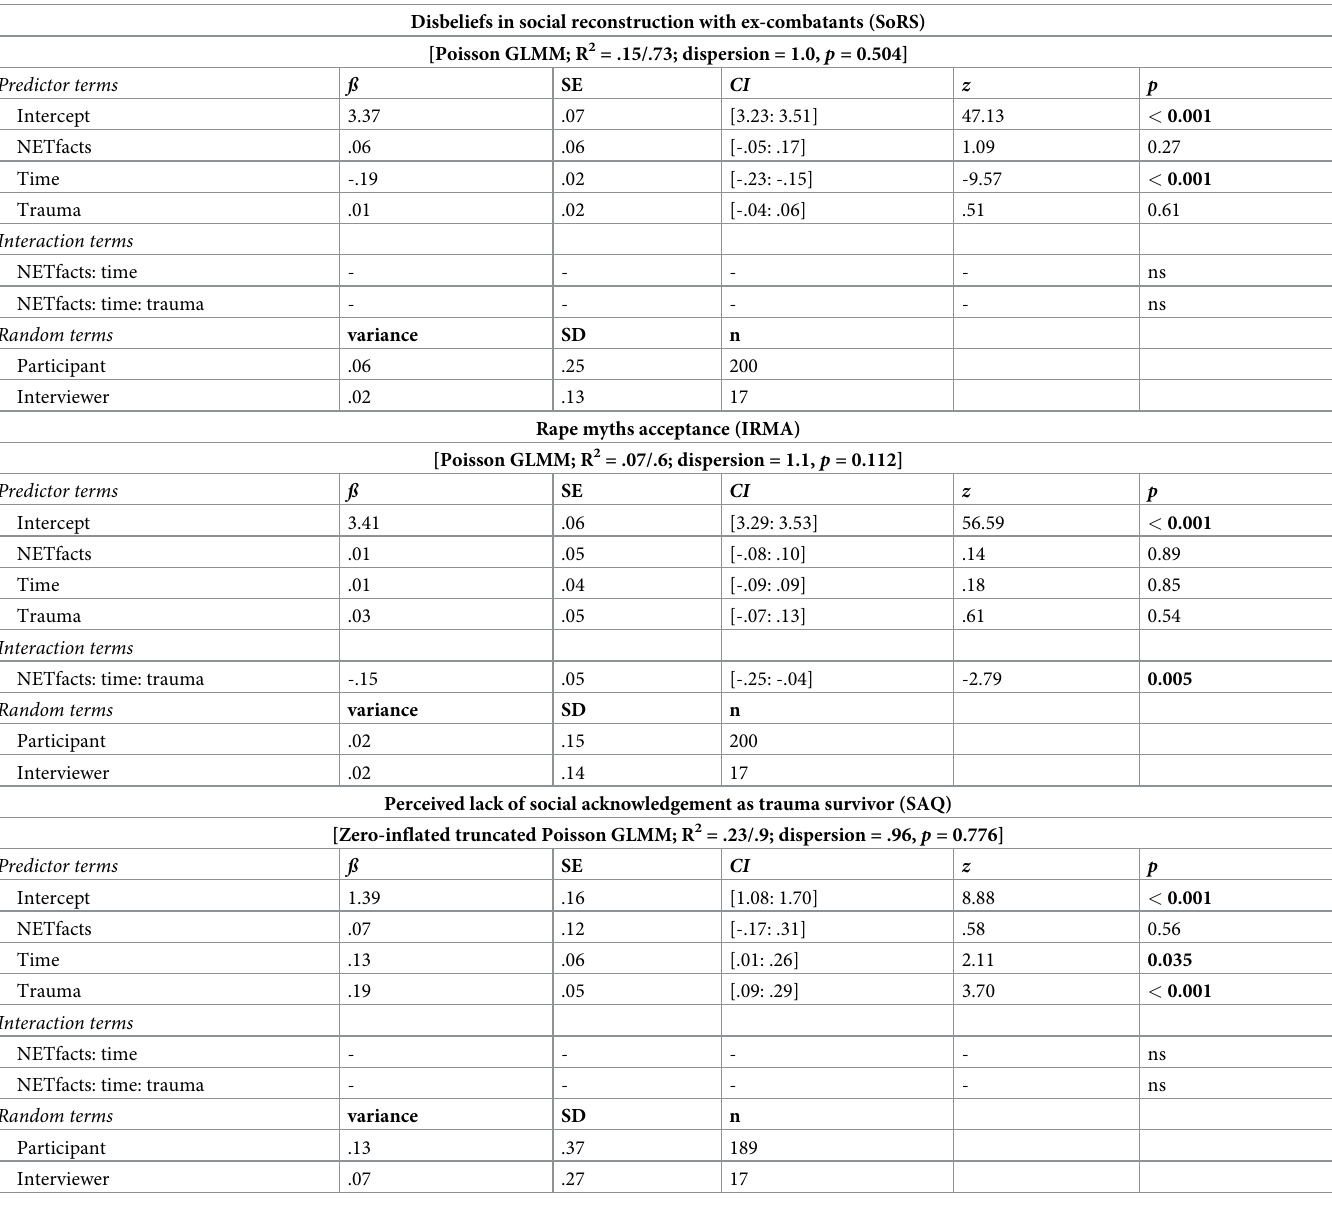
Table 2. GLMMs summary of the final models for disbeliefs in social reconstruction with ex-combatants, rape myths acceptance and social acknowledgement as trauma survivor (social outcomes). GLMMs were used to test the predictors of NETfacts (no direct vs. direct involvement), time (baseline vs. post follow up), trauma (number of traumatic events), and their interaction on sum scores for SoRS, IRMA and SAQ. Marginal and conditional R 2 fit, and dispersion test estimates are shown for each outcome. Standardized model estimates, standard errors, standardized confidence intervals, z and p values are shown for the predictor terms. Random terms are rep- resented as variance, standard deviation and sample size. Note that only the count model part of the zero-inflated GLMMs is shown here. Full GLMMs summaries includ- ing figures (and post hoc Tukey test for IRMA) are shown in S5–S7 Tables and S1–S3